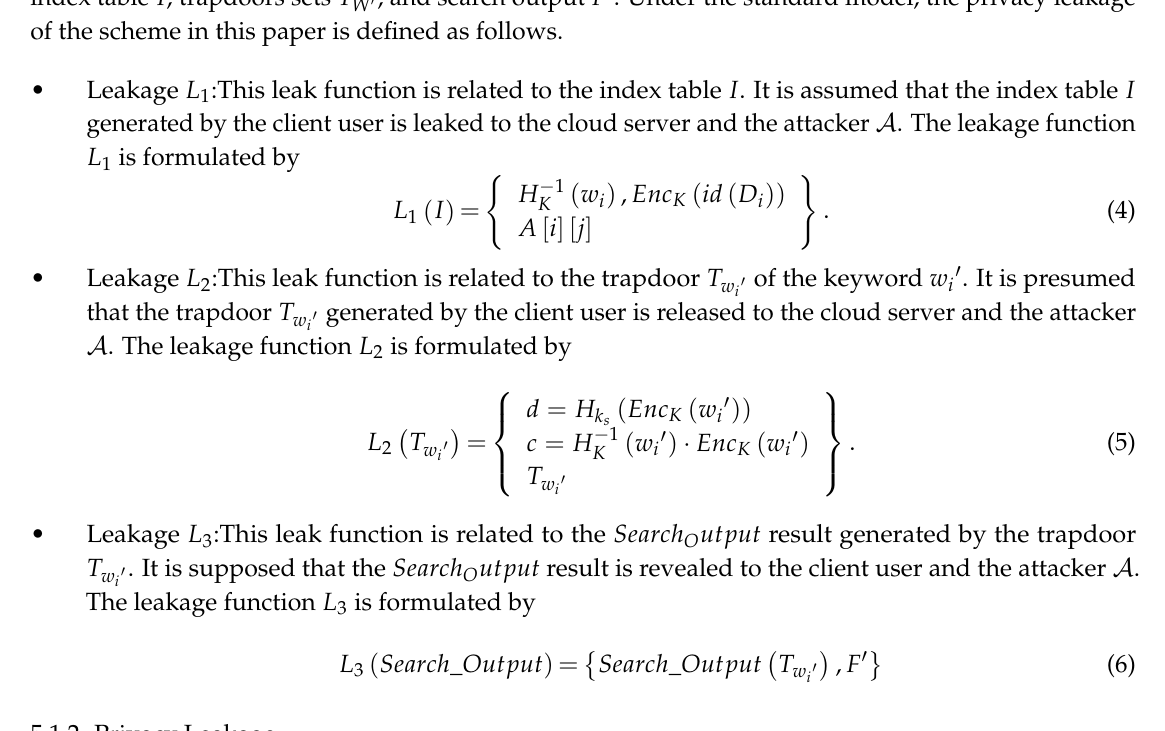
index table I , trapdoors sets T W (cid:48) , and search output F (cid:48) . Under the standard model, the privacy leakage of the scheme in this paper is defined as